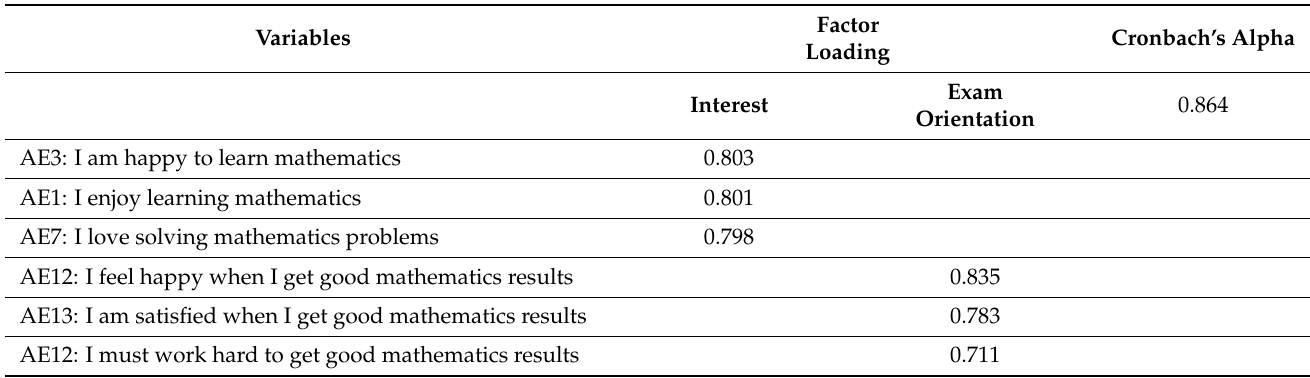
Table 4. Reliability values and factor loading for affective